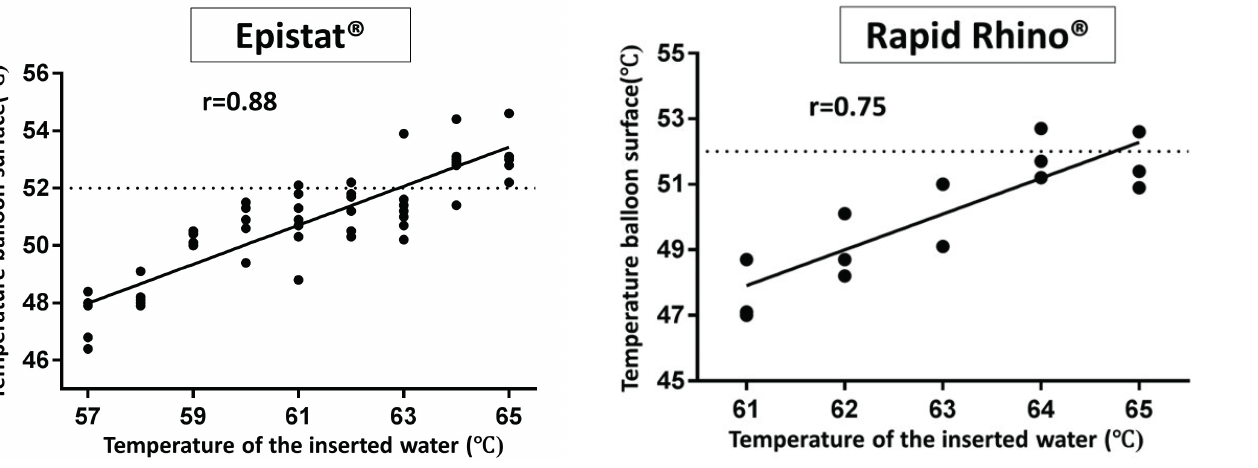
Figure 1. Water temperature versus maximum balloon surface tempera- ture for Epistat®. Please note that there is, as expected, a linear relation- ship between water temperature and maximum surface temperature. The dotted line indicates maximum surface temperature of 52 0C which has been shown to be the threshold for necrosis of nasal mucosa.